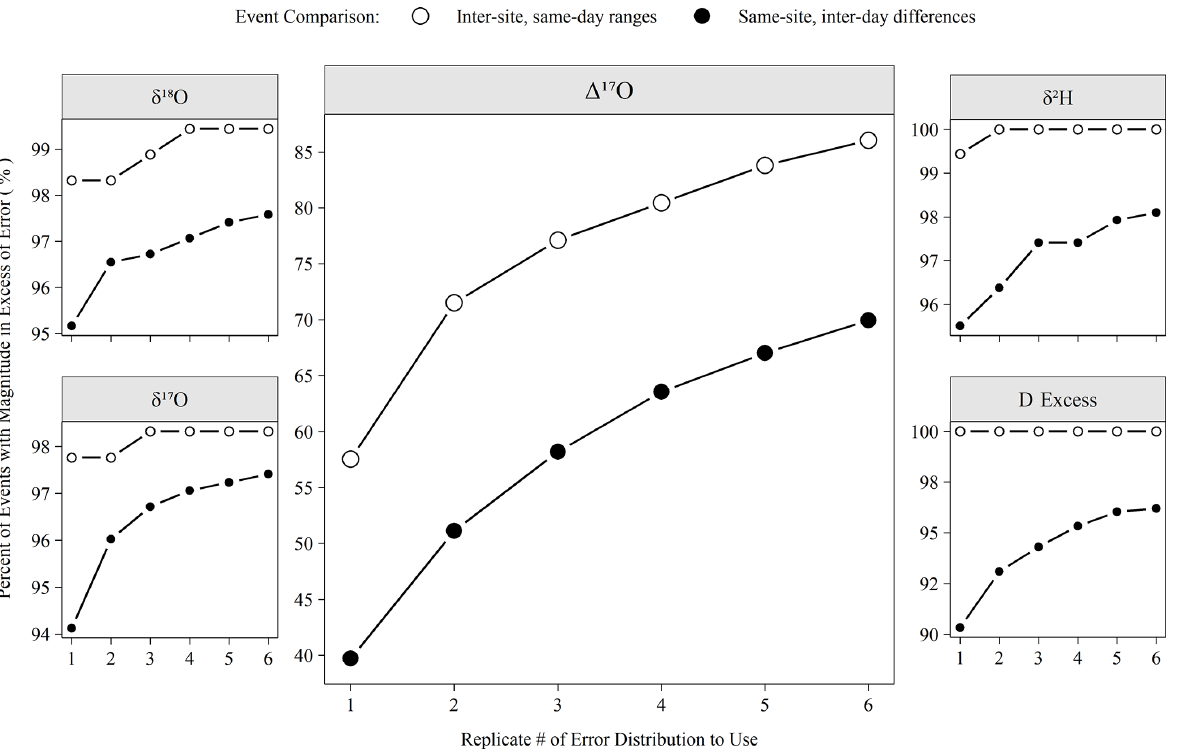
Figure 7. The percentage of meteoric precipitation events captured by varying numbers of analytical replicates. Inter-site, same-day ranges are the range of all sites from a Ugandan monitoring network (see Sect. 2.1). Same-site, inter-day differences are the differences of measured isotope values between sequential precipitation events ( < 7d span). If the event magnitude (either range or difference) exceeded the error for a given replicate number (Fig. 6), then it is considered here